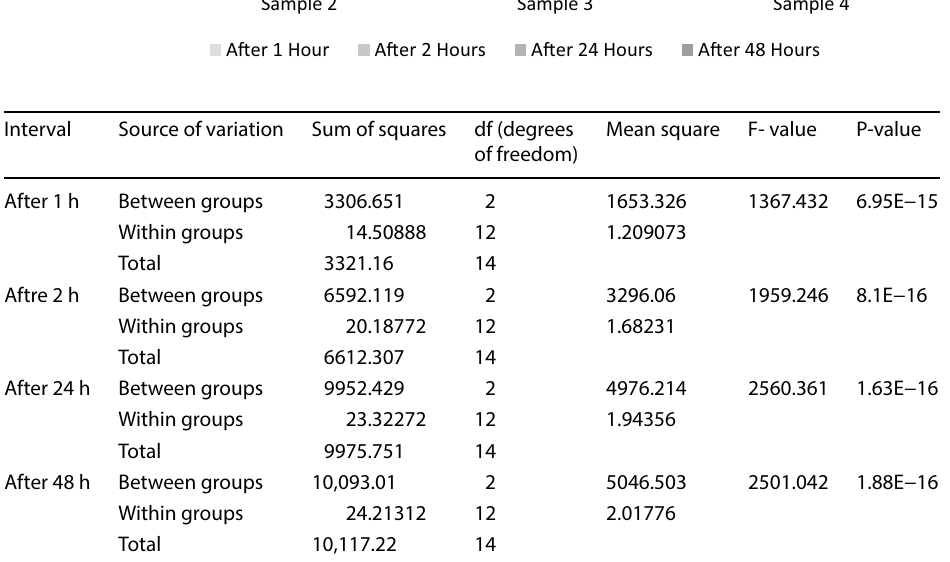
Hydroxide and 2% Adipic Acid and 1% Mustard Oil, and